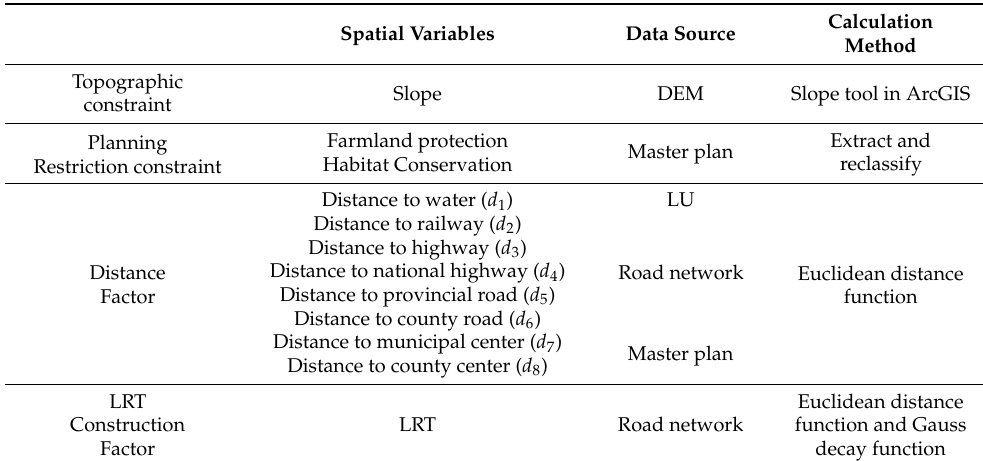
Table 1. Spatial variables applied to build the CA